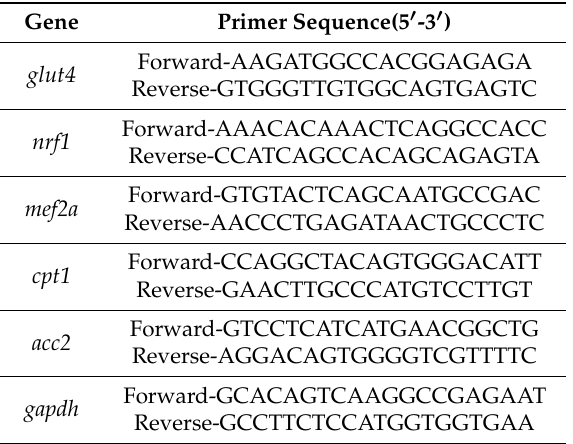
Table 5. Primers sequences for quantitative reverse transcription polymerase chain (qRT-PCR) reaction.